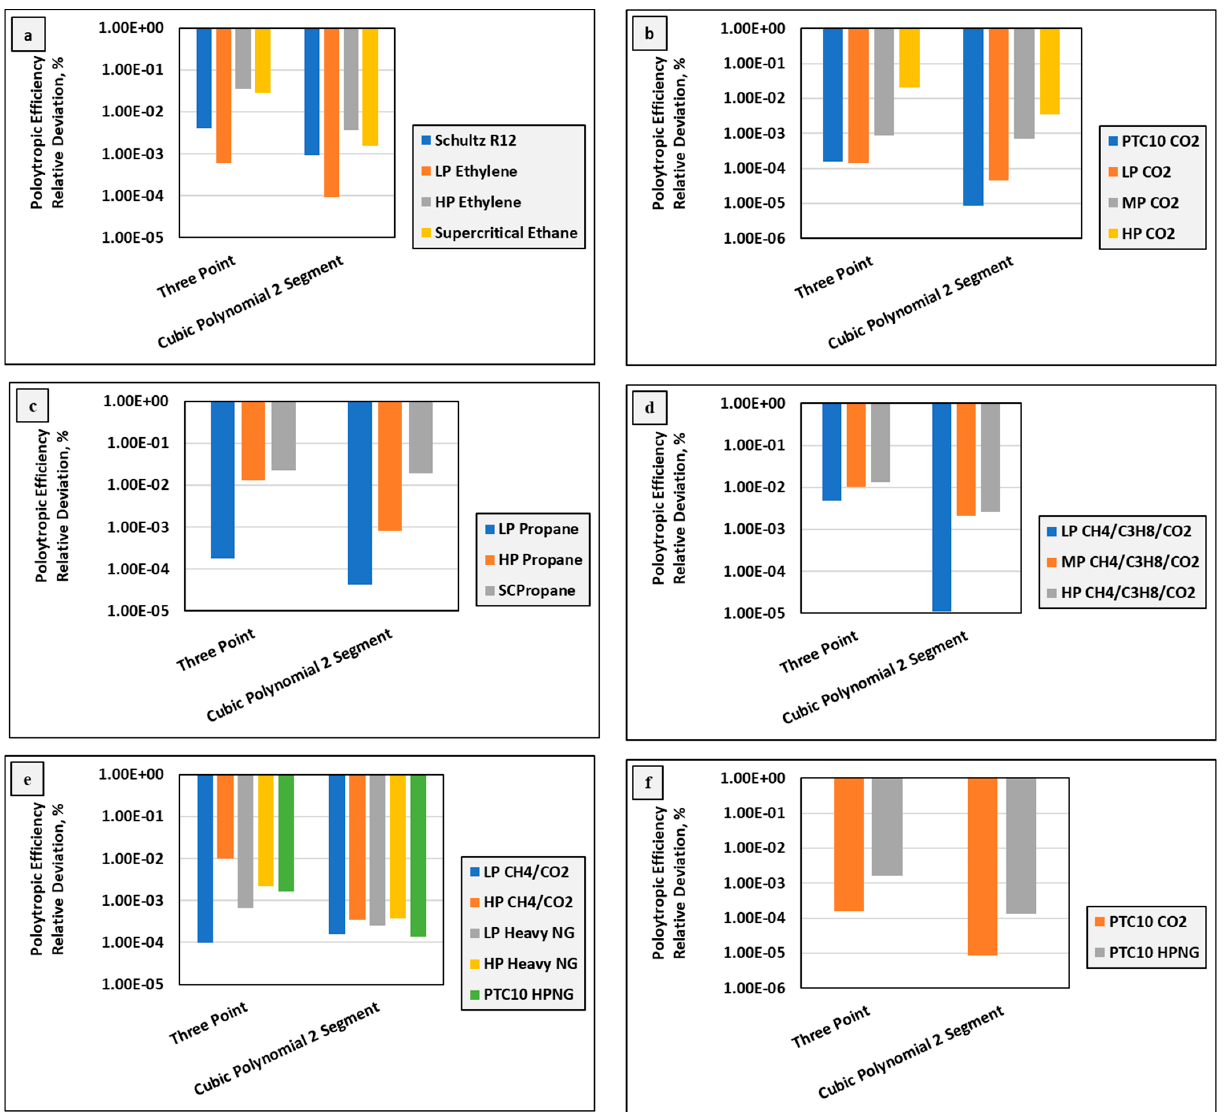
Figure A2. ( a – f ) Summary comparison of relative deviation results for three point